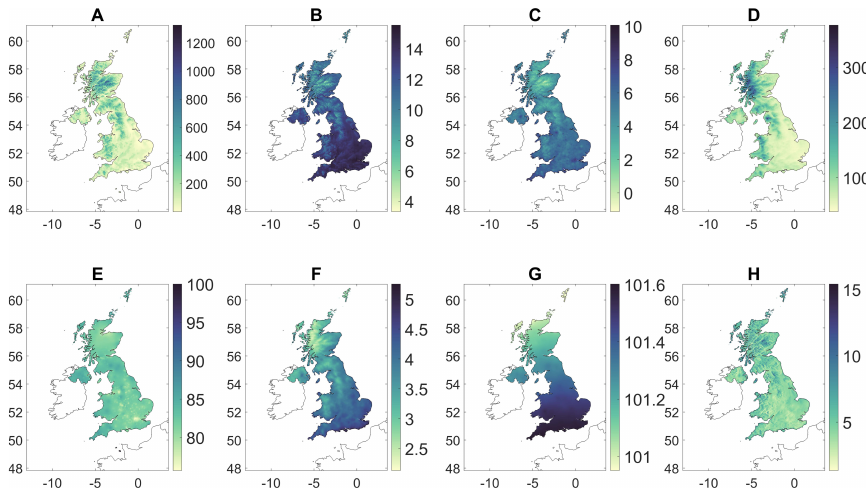
Figure 1. Average yearly spatial distribution of climatic data and elevation: ( A ) elevation (m), ( B ) average air maximum temperature ( ◦ C), ( C ) average air minimum temperature ( ◦ C), ( D ) total average monthly cumulative precipitation (mm), ( E ) average relative humidity (%), ( F ) average daily sunshine hours (h), ( G ) average sea level pressure (kPa) and ( H ) average wind speed